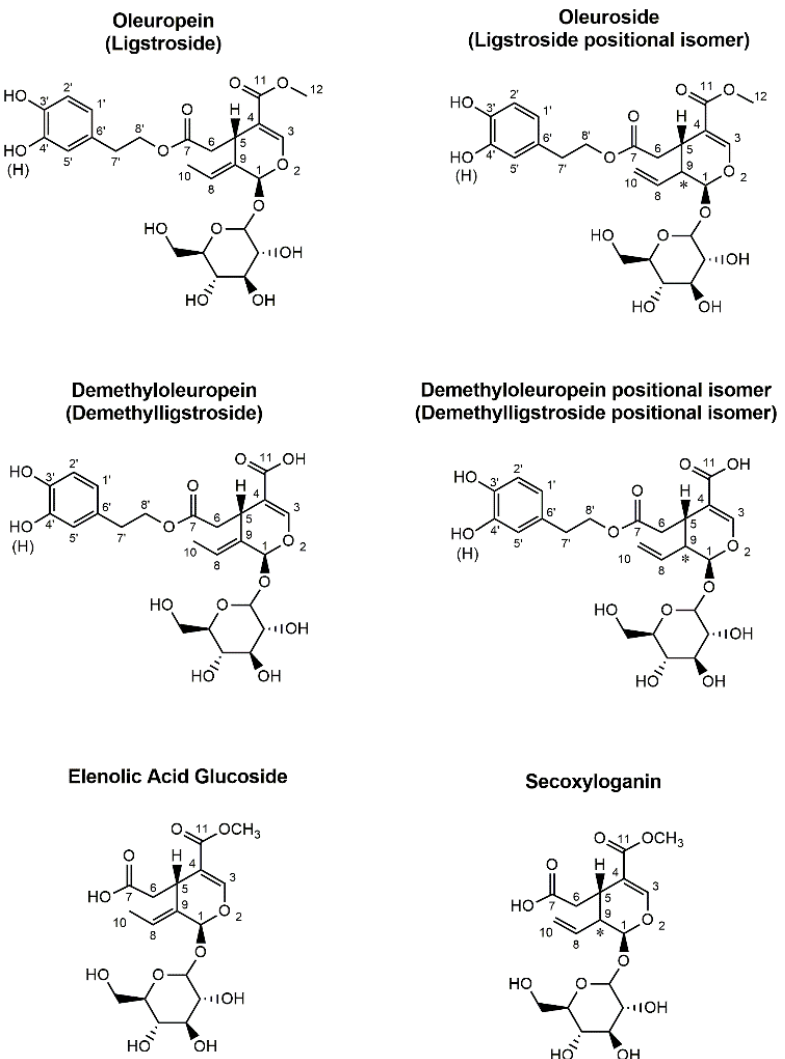
Figure 1. Molecular structures of secoiridoids characterized in extracts of leaves and drupes of the olive plant during the present study. Names in parentheses correspond to structures in which a H atom replaces the OH group on carbon atom 4 ′ .